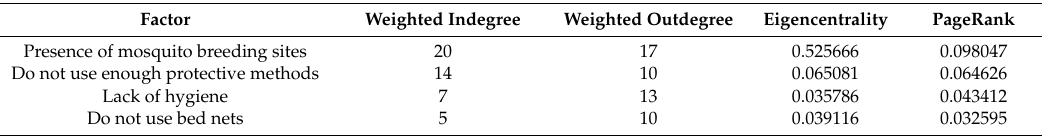
Table 5. Network statistics of key